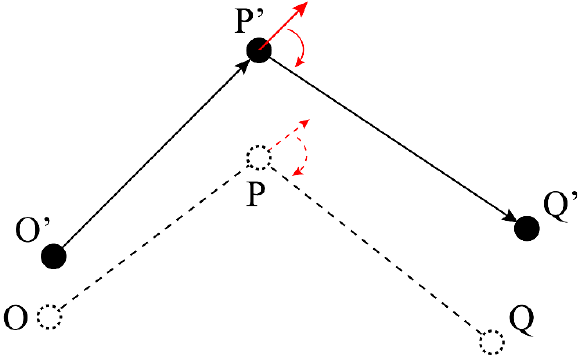
Figure 7. Position error when moving from one target point to the next one. In Figure 7, the straight arrows in red represent the forward direction when the robot reach the points P and P (cid:48) . And the curved arrows in red represent the rotation movements before moving to the points Q and Q (cid:48) . Before the mobile robot moves from point P (cid:48) to point Q (cid:48) , the mobile robot turns in situ. The ideal turning angle θ P is